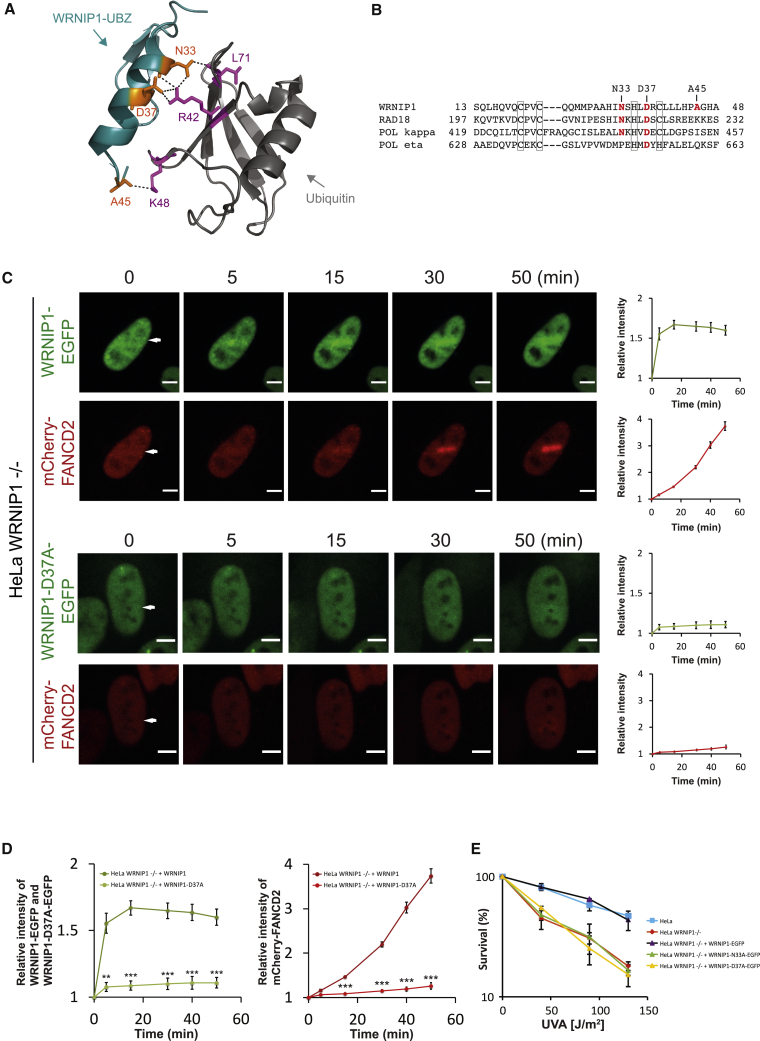
The UBZ Domain of WRNIP1 Is Necessary for Its Recruitment to ICLs(A) Three potential polar interactions between WRNIP1’s UBZ domain and ubiquitin are indicated with dashed lines (GFP-WRNIP1 UBZ/ubiquitin, PDB: 3VHT).(B) Alignment of UBZ domains from WRNIP1, RAD18, polymerase kappa, and polymerase eta. Amino acids coordinating zinc are shown in black boxes. Amino acids forming contacts to ubiquitin are shown in red.(C) Live-cell imaging of WRNIP1-EGFP, WRNIP1-D37A-EGFP, and mCherry-FANCD2 in HeLa WRNIP1−/− cells. Cells were treated with TMP, microirradiated at the indicated areas (white arrows), and followed over time. Quantification shows relative intensities of the irradiated areas. 4 cells were quantified for each chart (mean ± SEM). Scale bar, 10 μm.(D) Combination of quantification data from (C). Recruitment of WRNIP1-EGFP and WRNIP1-D37A-EGFP is shown in green and light green, respectively, on the chart on the left. Recruitment of mCherry-FANCD2 in cells expressing WRNIP1-EGFP or WRNIP1-D37A-EGFP is shown in red and light red, respectively, on the chart on the right. ∗∗p < 0.01, ∗∗∗p < 0.001 (mean ± SEM).(E) Clonogenic survival assay of HeLa cells and derivative cell lines in response to TMP/UVA. The presented data represents 2 independent experiments with 3 technical repeats each (mean ± SEM, n = 2).